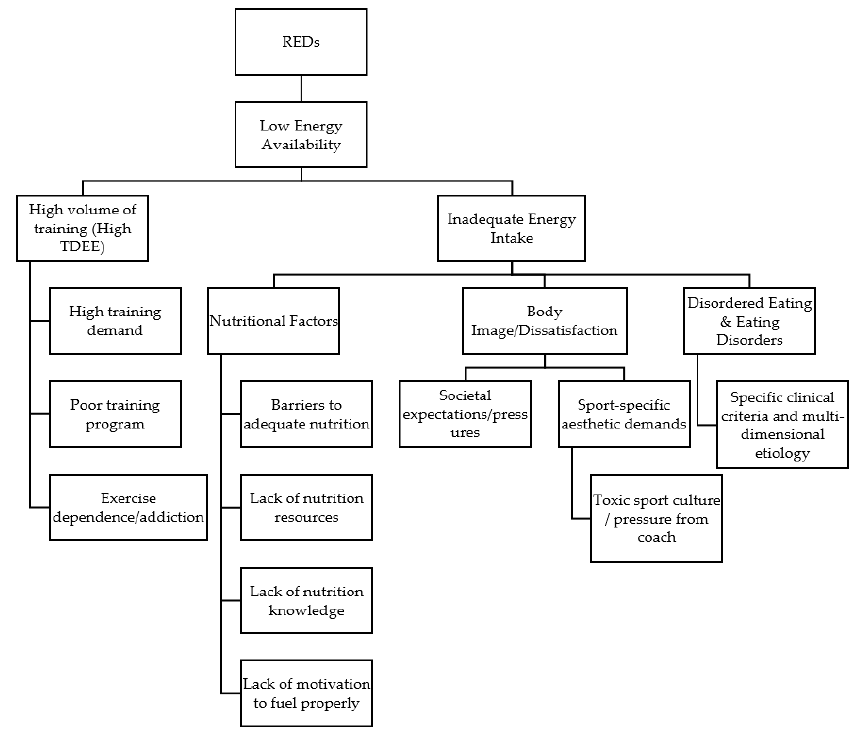
Figure 1. A theoretical framework outlining potential risk factors and contributors to LEA and RED-s.